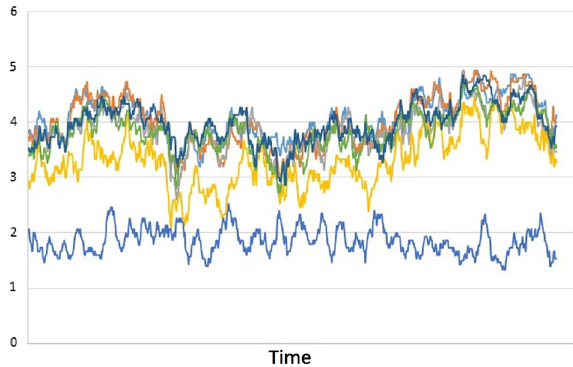
Fig. 6 The running-average series of responses to 7 different questions in the